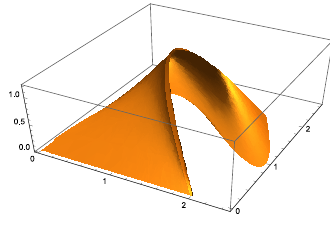
Figure 3: The ( q , h ) -Bézier surface.